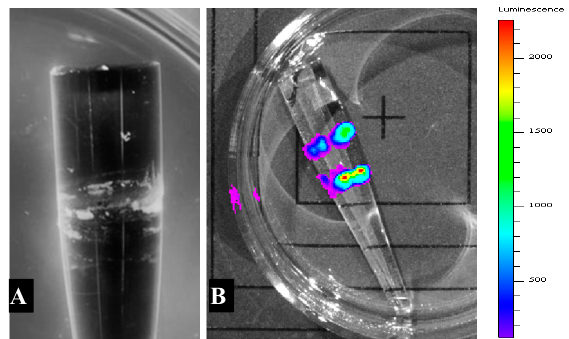
Figure 8. ( A ) E. coli 652T7 on the surface of an APTES modified quartz cone after four days in Lauria-Bertani (LB) Kan cultivation medium. ( B ) Bioluminescence of E. coli 652T7 induced after immersion in LB medium as measured in an IVIS Lumina K imager (photons / sec / cm 2 /